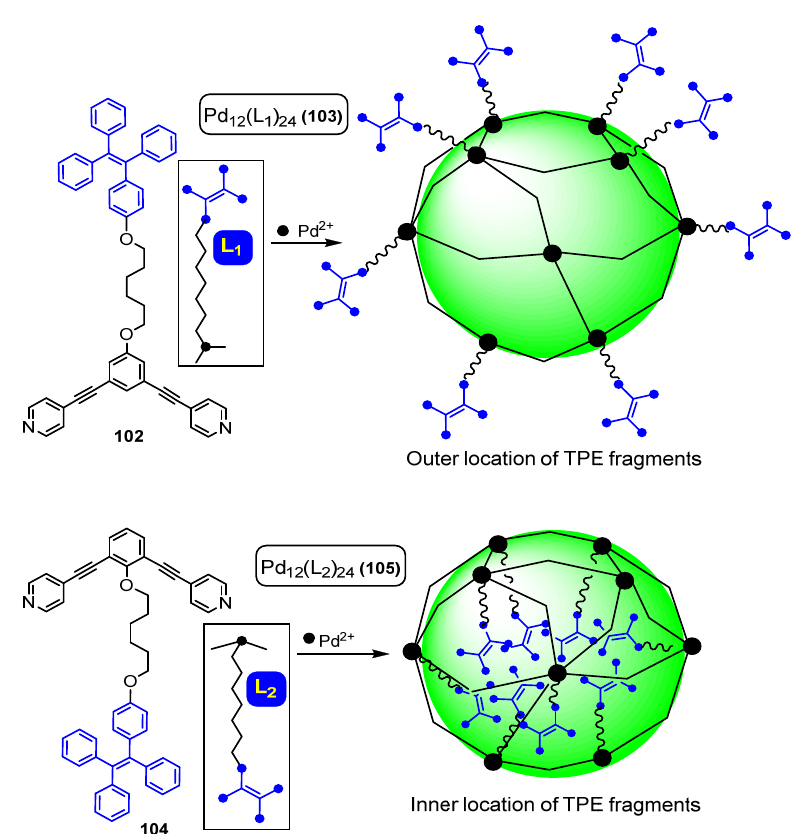
Figure 29. Schematic representation of complexes Pd 12 L 24 (not all groups shown) with the bis(pyridin)-TPE derived ligands pointing towards the outer part of the Pd 12 sphere ( up ) or towards the inner part ( down ). Adapted from [104].